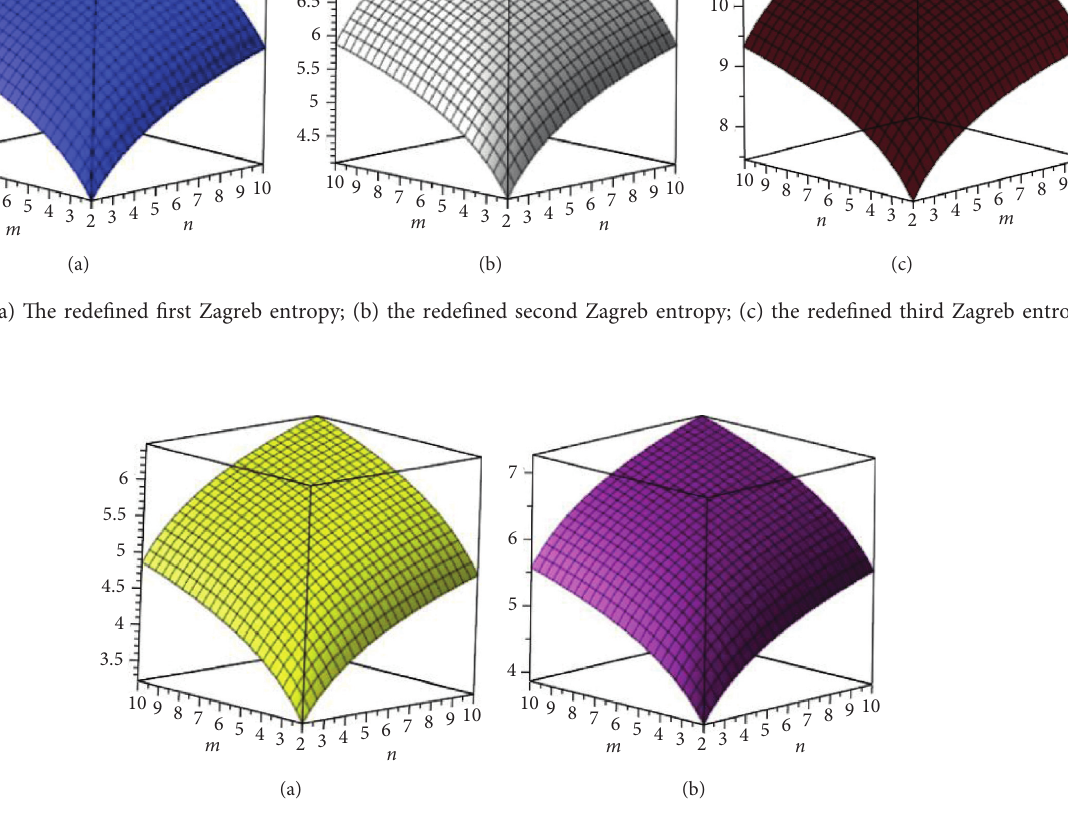
entropy; (b) the GA 4